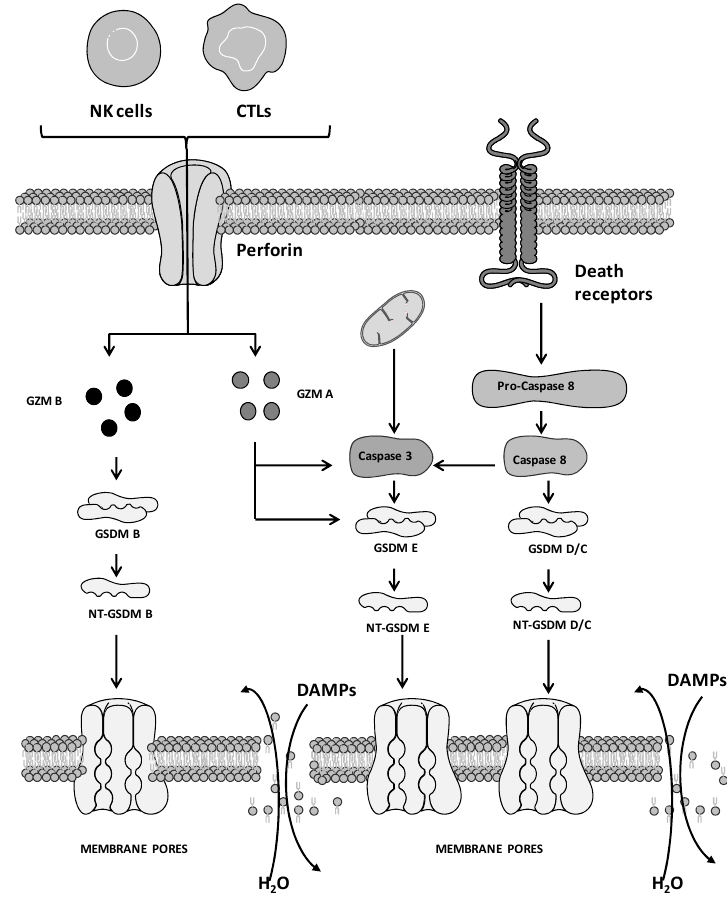
Figure 2. Caspase ‐ independent and caspase 3/8 ‐ dependent mechanisms of pyroptosis. The figure is Figure 2. Caspase-independent and caspase 3/8-dependent mechanisms of pyroptosis. The figure is prepared using tools from Servier Medical Art (http://www.servier.fr/servier ‐ medical ‐ art (accessed prepared using tools from Servier Medical Art (http://www.servier.fr/servier-medical-art (accessed on 1 November 2022). on 1 November